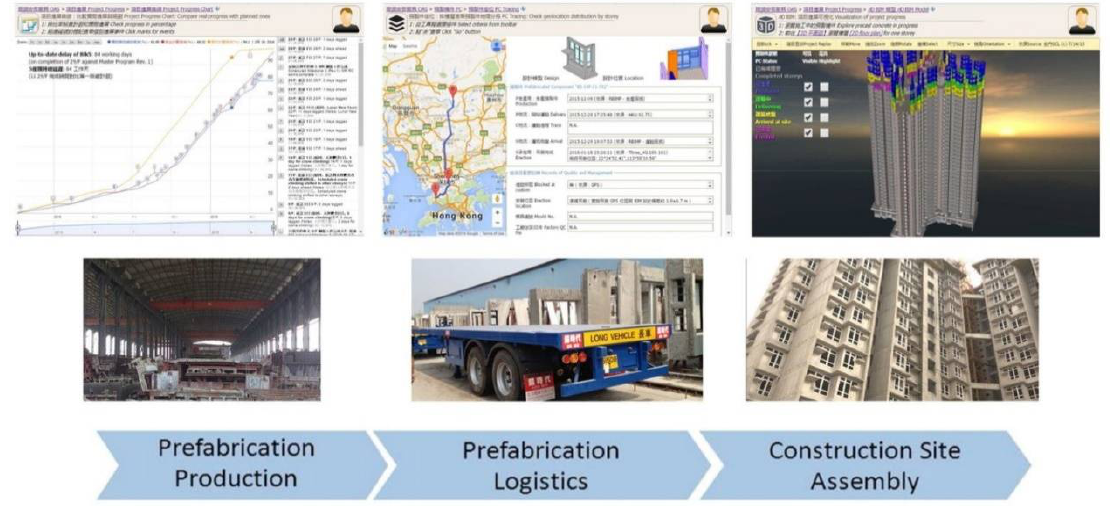
Figure 4. Visibility tools for MITBIMP. Reprinted/Adapted with permission from Reference [35].